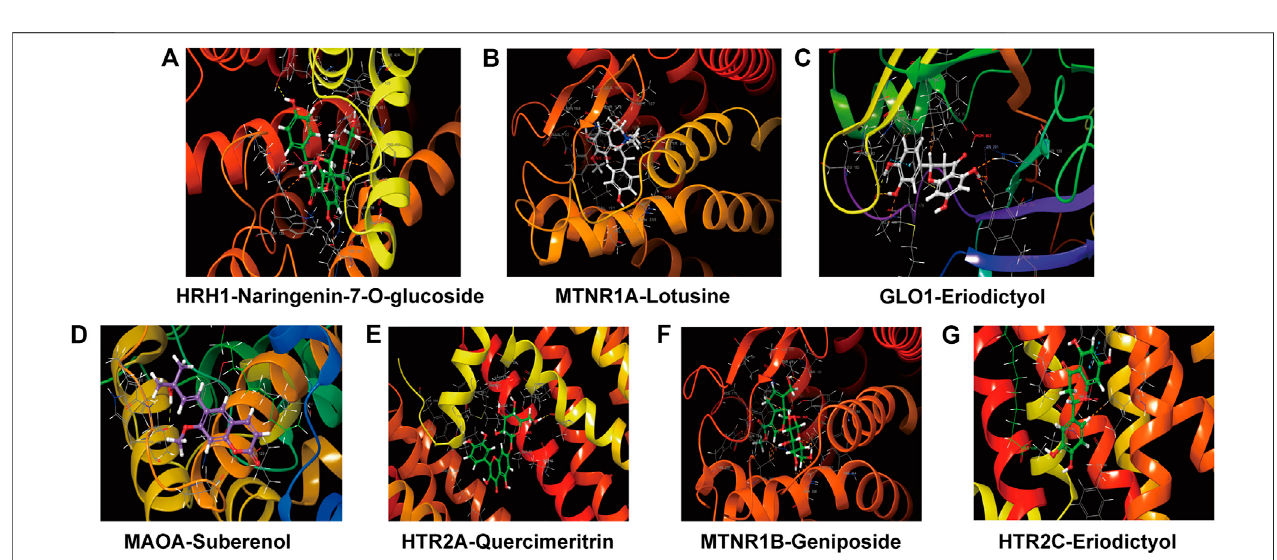
FIGURE 8 | Molecular docking of representative compounds and related receptors. The 3D diagram of the docking of HRH1 with Naringenin-7-O-glucoside (A) , MTNR1AwithLotusine (B) ,GLO1withEriodictyol (C) ,MAOAwithSuberenol (D) ,HTR2AwithQuercimeritrin (E) ,MTNR1BwithGeniposide (F) ,HTR2CwithEriodictyol (G) .